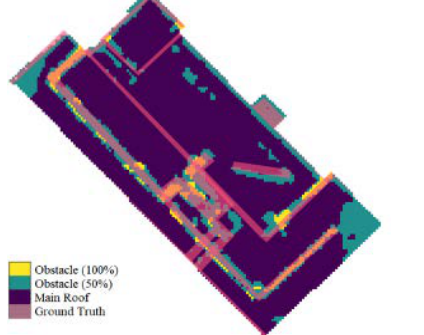
Figure 5 . Comparison between the inferred obstacles and ground truth for a sample building